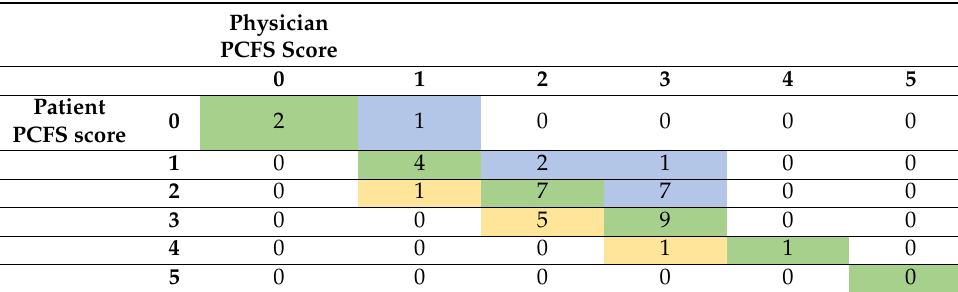
Table 1. Agreement and disagreement in PCFS scores between patient self-reporting and physician interviews. Green boxes indicate agreement between both ratings; blue boxes indicate a lower self-reporting score compared to the physician interview; and yellow boxes indicate a higher self- reporting score compared to the physician interview. Abbreviations. PFCS: post-COVID-19 functional status